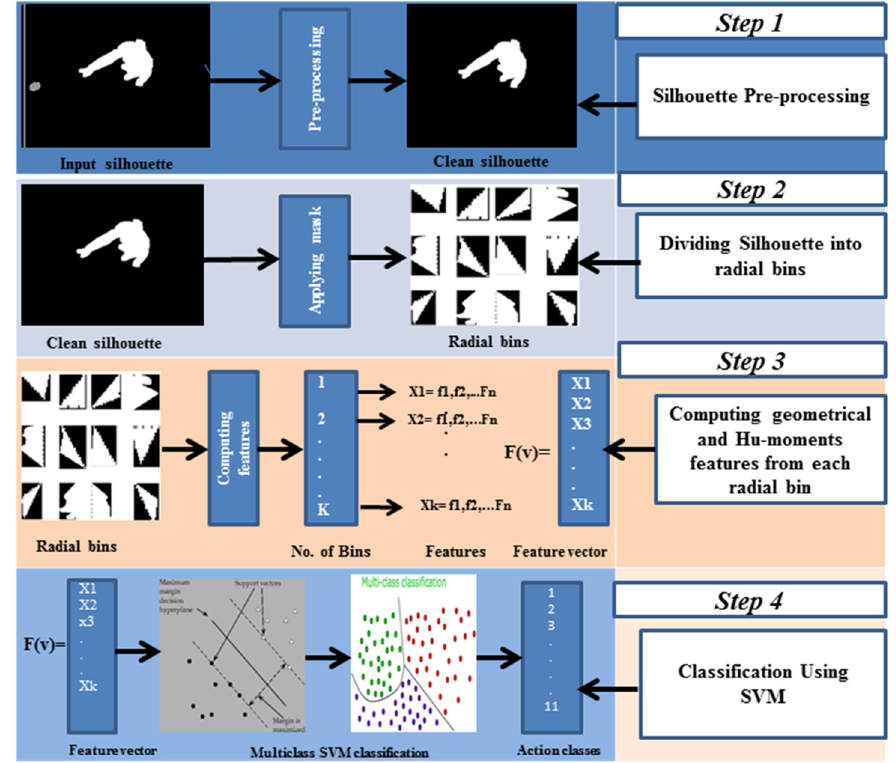
Figure 1. Block diagram of the proposed system.